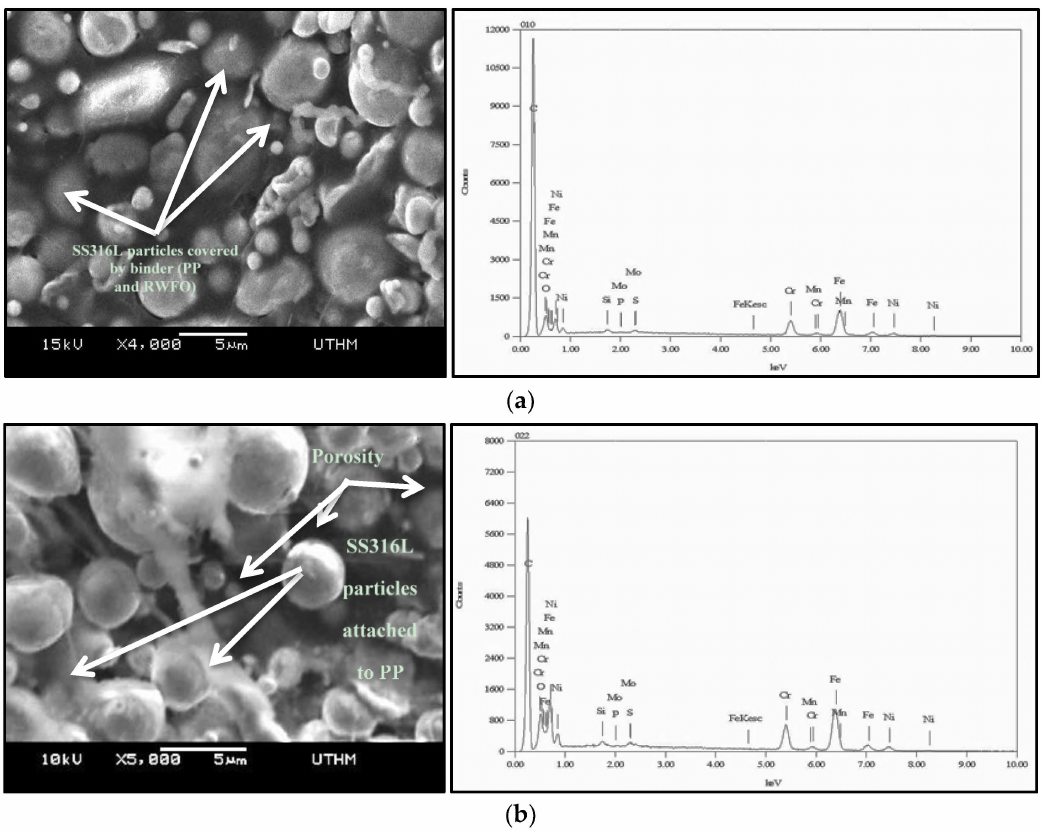
Figure 15. Scanning Electron Microscope (SEM) and Energy Dispersive Spectroscopy ( a ) Green compact morphology ( b ) green compact after 3 h solvent